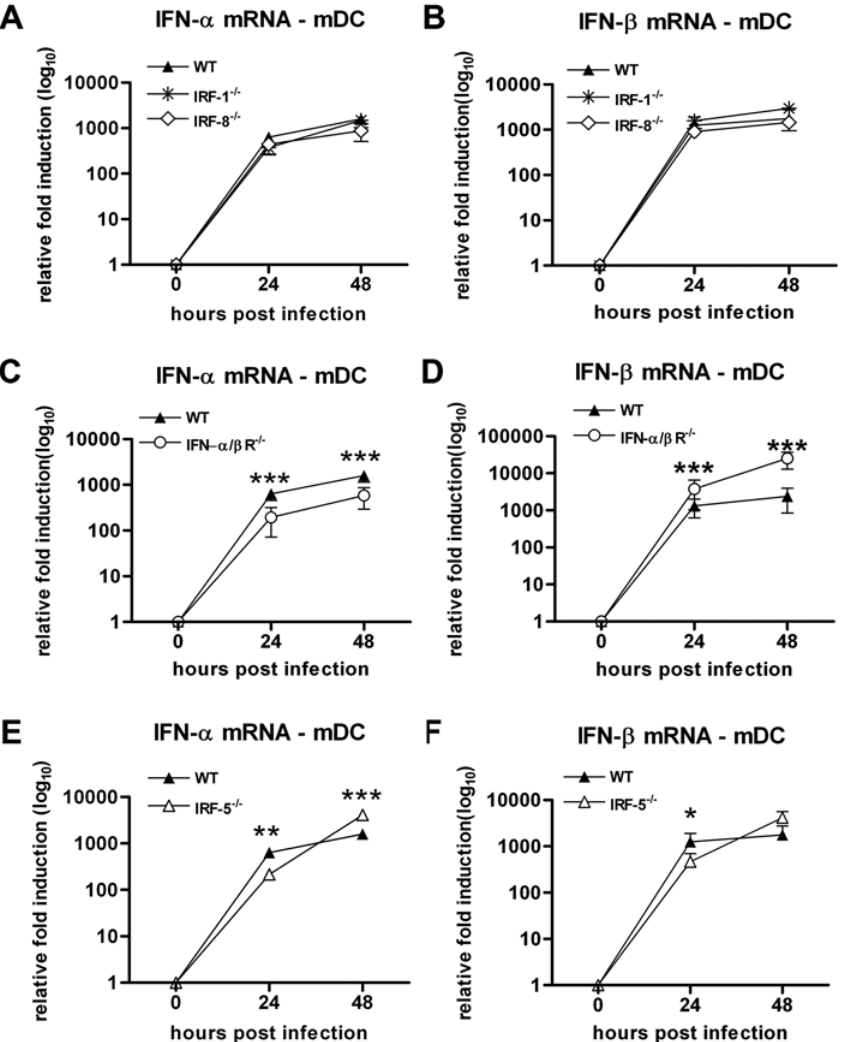
Figure 8. The IFN- b response in mDC is IRF-1, IRF-8, IFN- a / b -independent but partially IRF-5-dependent. mDC generated from wild type, ( A and B ) IRF-1 2 / 2 , IRF-8 2 / 2 , ( C and D ) IFN- a / b R 2 / 2 , or ( E and F ) IRF-5 2 / 2 mice were infected at an MOI of 0.1 and levels of IFN- a ( A , C , and E ) and IFN- b ( B , D , and F ) mRNA were measured by qRT-PCR. Values are an average of triplicate samples generated from three independent experiments. Asterisks indicate values that are statistically significant (***, P , 0.0001, **, P , 0.005, *, P , 0.05) compared to wild